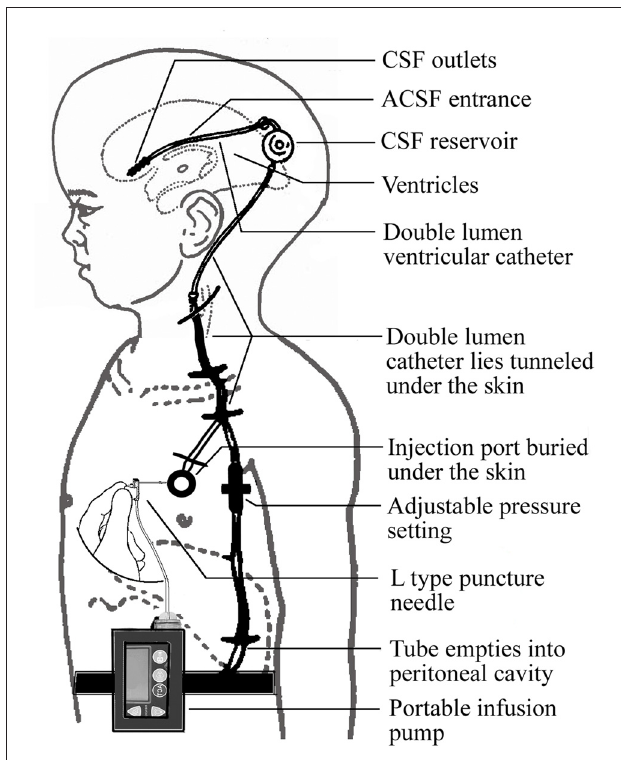
FIGURE 2 | Schematic diagram of the CSF circulatory assistance device.